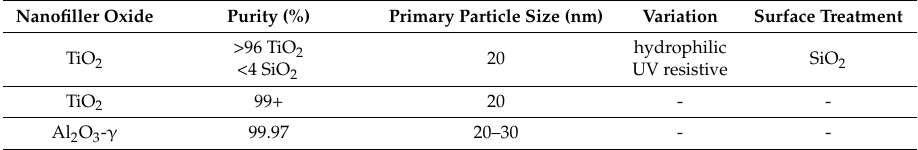
Table 6. Overview of selected nanoparticles to modify new oil